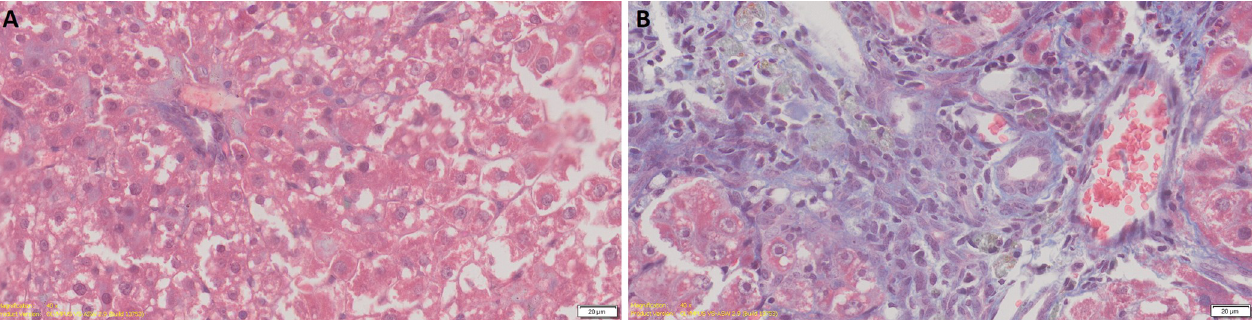
Fig 9. Masson staining of CCA model. (A) rat liver after 5 weeks of feeding water containing TAA, 40x. (B) rat liver after 16 weeks of feeding water containing TAA, 40x.